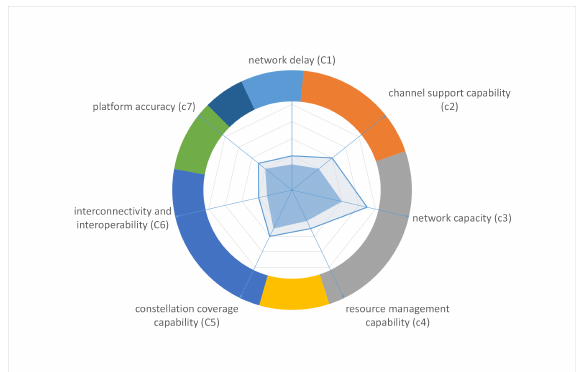
Figure 8. The effectiveness comparison in radar